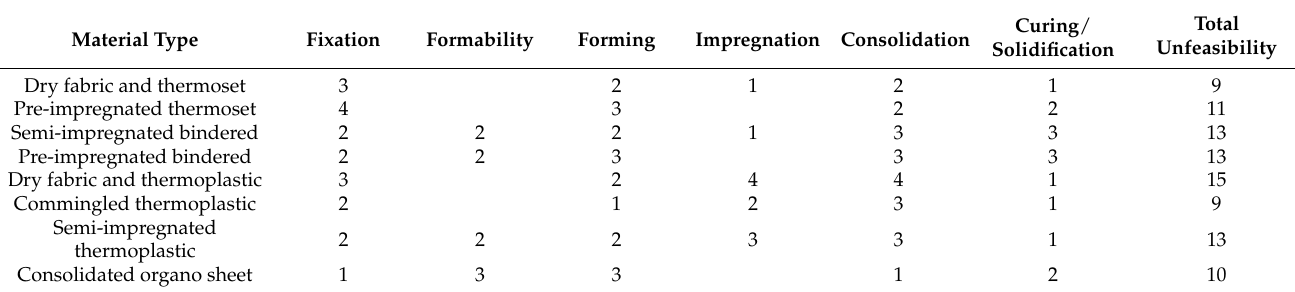
Table 1. Matching material types and processing functions, rating match feasibility from 1 (feasible) to 4 (hardly feasible).